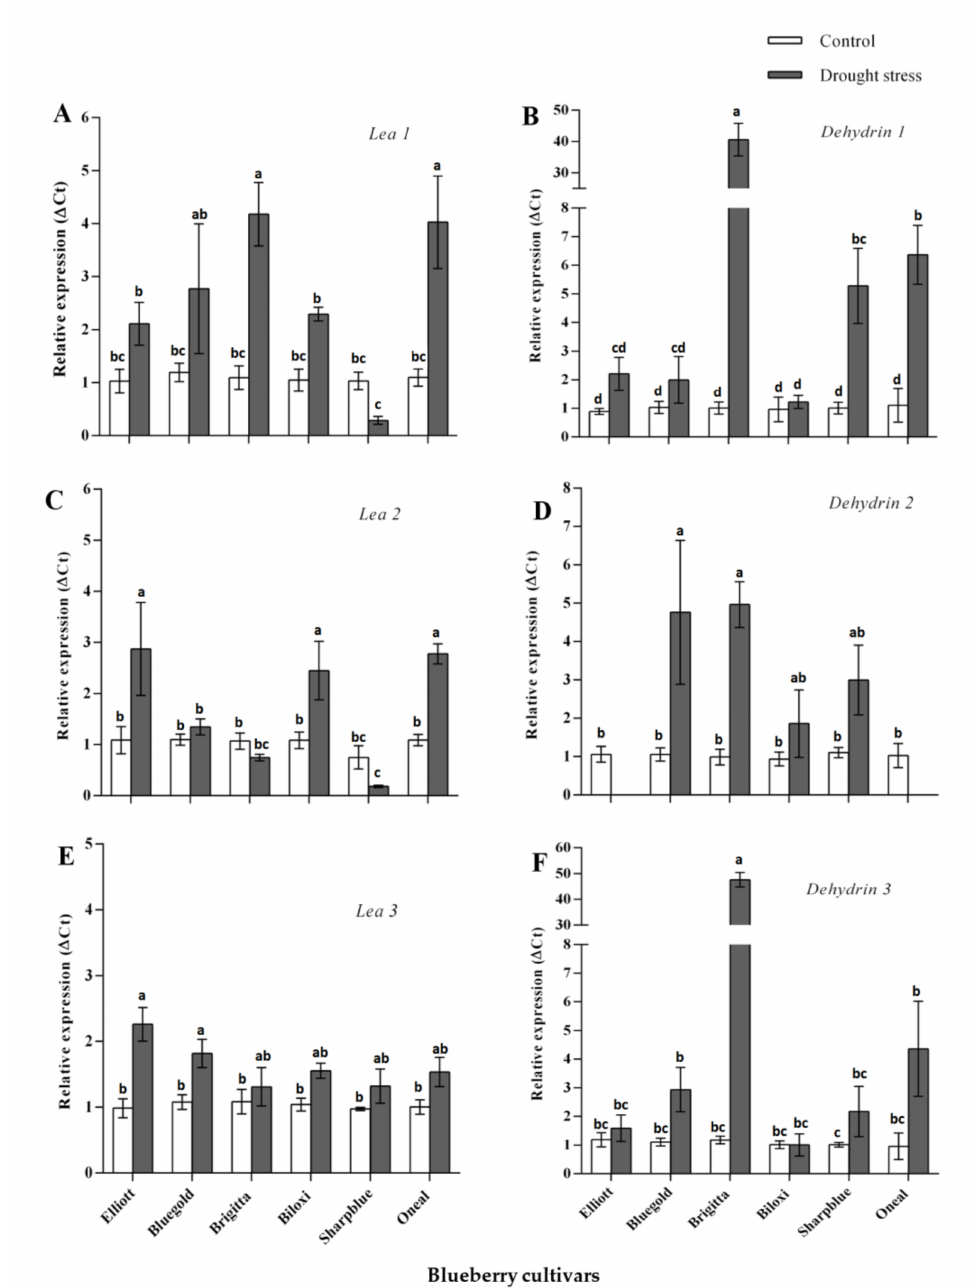
Figure 3. Relative expression of candidate genes from the Late Embryogenesis Abundant (LEA) family (normalized with ACT7 ) at six weeks after drought stress. ( A ): LEA 1 relative expression; ( B ): Dehydrin 1 relative expression; ( C ): LEA 2 relative expression. ( D ): Dehydrin 2 relative expression; ( E ): LEA 3 relative expression; ( F ): Dehydrin 3 relative expression. White bars, control conditions and grey bars, drought stress conditions. Standard error bars are shown. Significant di ff erences were found according to two-way ANOVA and Tukey’s test ( p value <